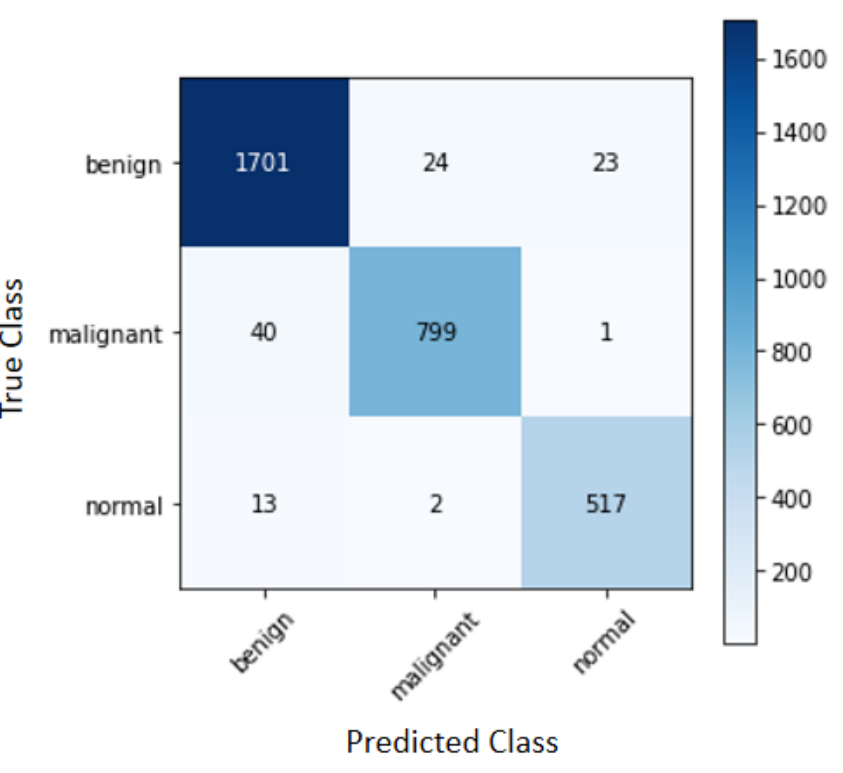
Figure 7. Confusion matrix for the combination of the Bilateral algorithm with the SVM classifier.